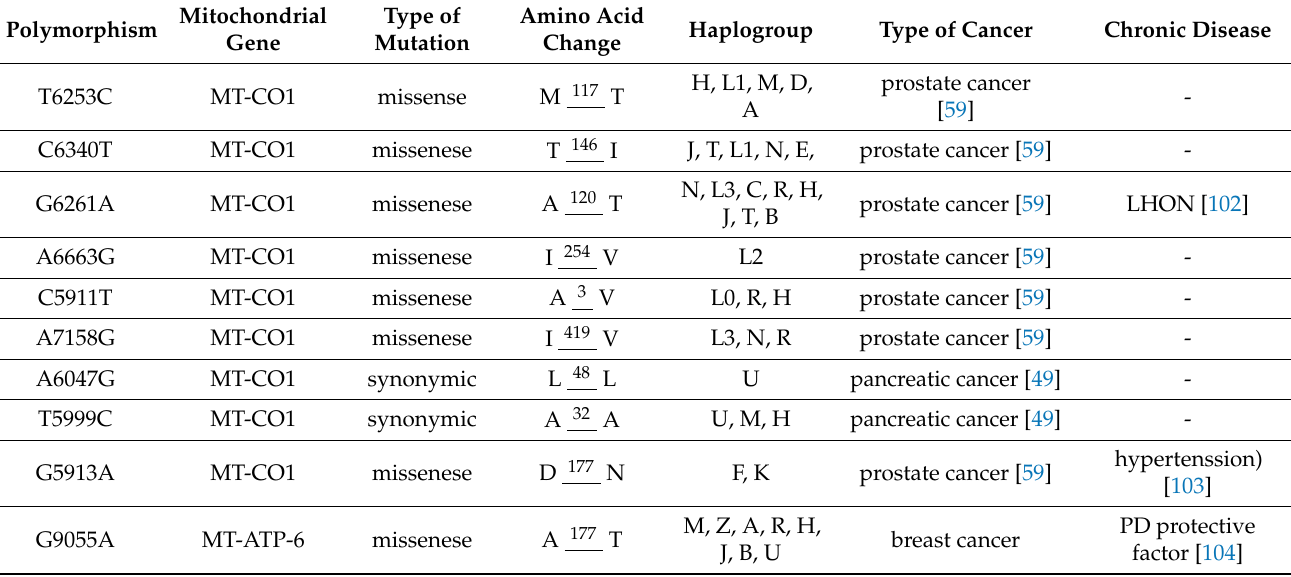
Table 1. The resume of changes in mtDNA associated with